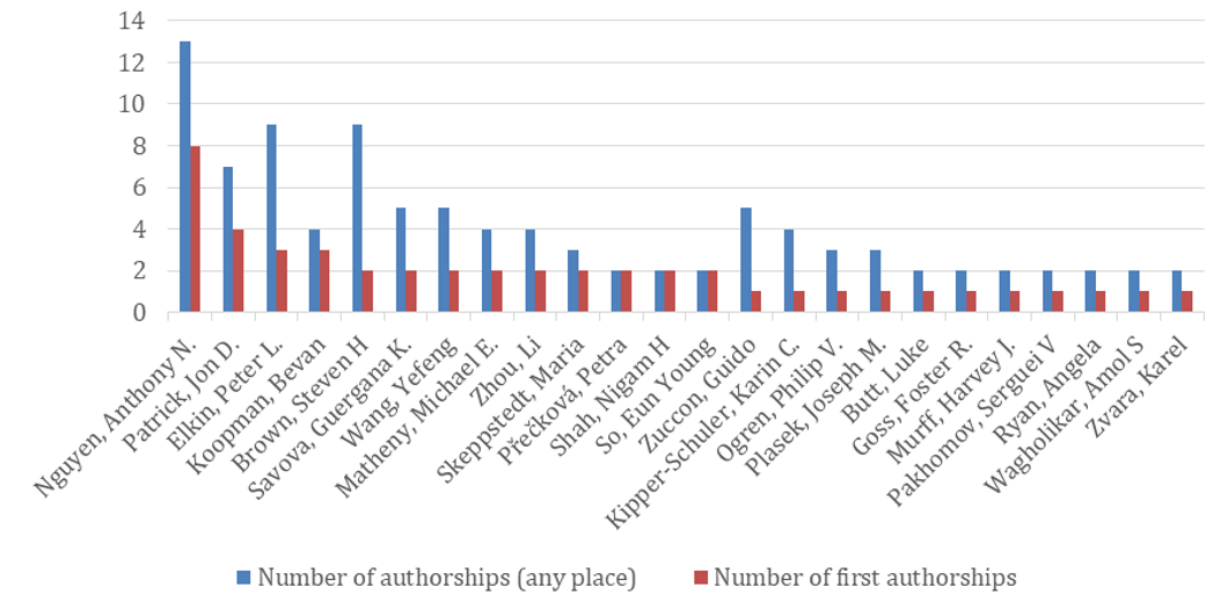
Figure 3. Number of authorships for the most prolific authors in selection.